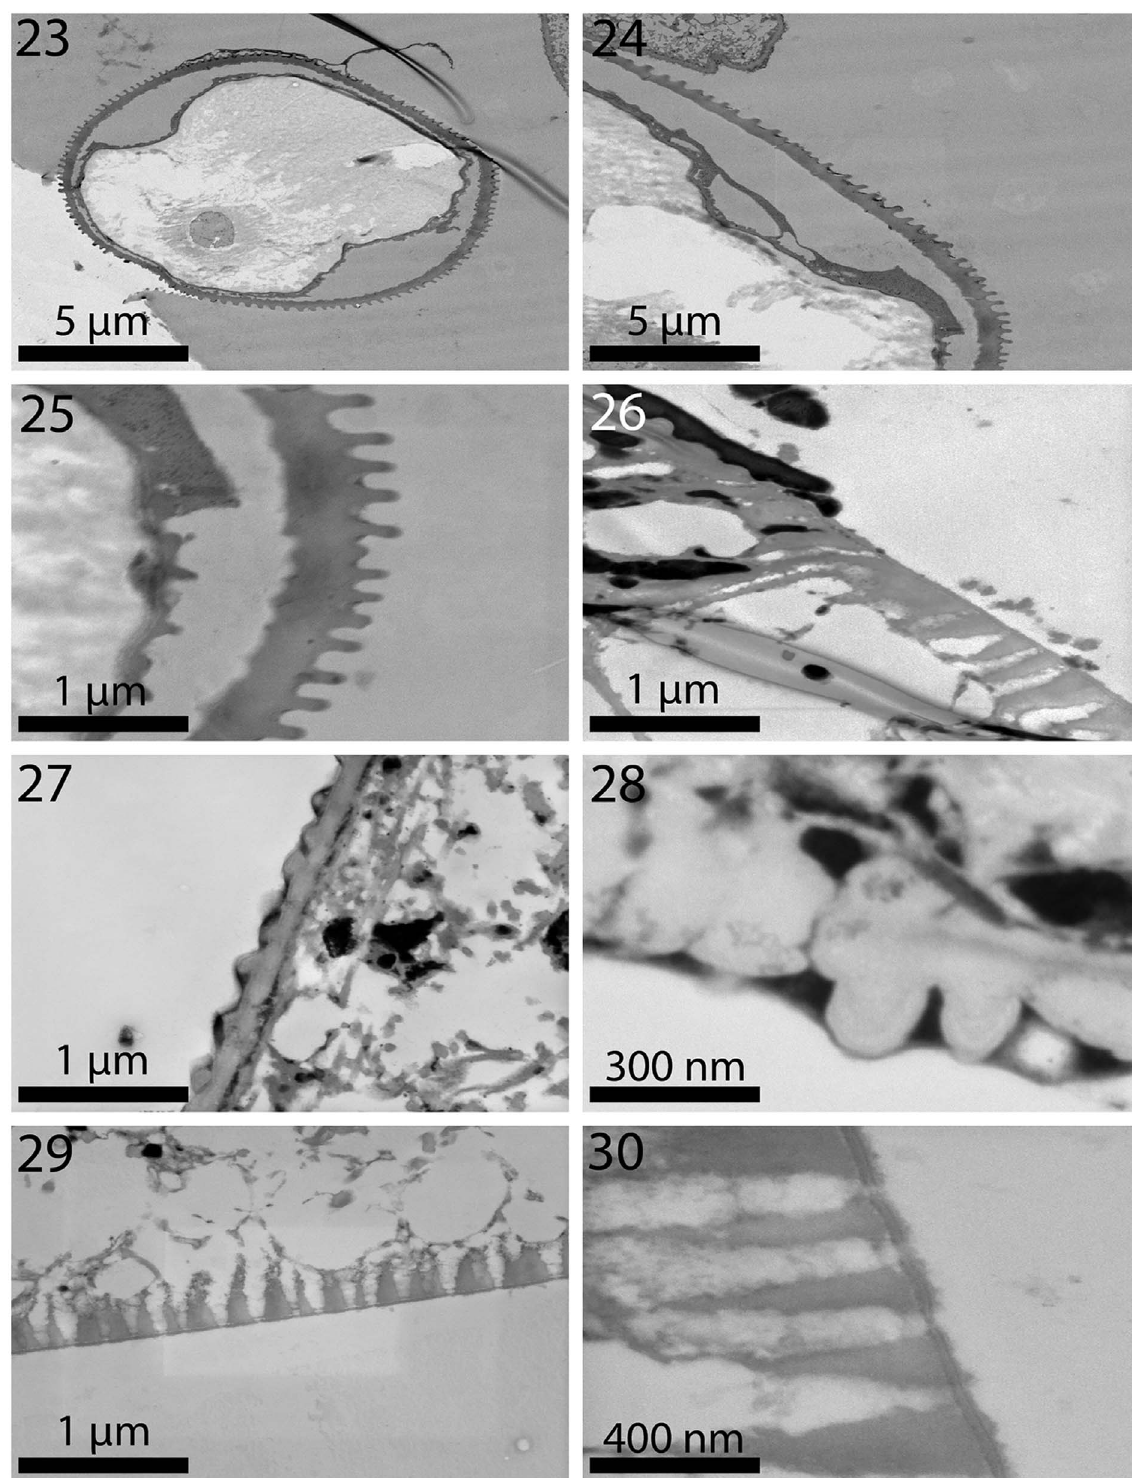
Figures 23 – 30. TEM sections of specimens of Neoechinorhynchus personatus from Mugil cephalus in the Mediterranean Sea off Tunisia. 23. Cross section of a hook. Note the serrated (corrugated) outer layer and the solid inner core with an internal tube. 24. Higher magni fi cation of pert of the hook in Fig. 23 showing the outer serrated layer. 25. Outermost layer of the hook showing detail toothed serrations. 26. Transition between the neck (top) and trunk (bottom with micropore tubules) of a worm. 27. Outer tegument layer of the neck with a knobby (pebbled) surface. No visible micropore channels here. 28. A high magni fi cation of the neck tegument in Fig. 27. Note distinct outer layer and myo fi brils beneath the tegument. 29. Part of the trunk tegument of a worm showing micropore channels. 30. A higher magni fi cation of a section of the tegument in Fig. 29 showing detail of the micropore